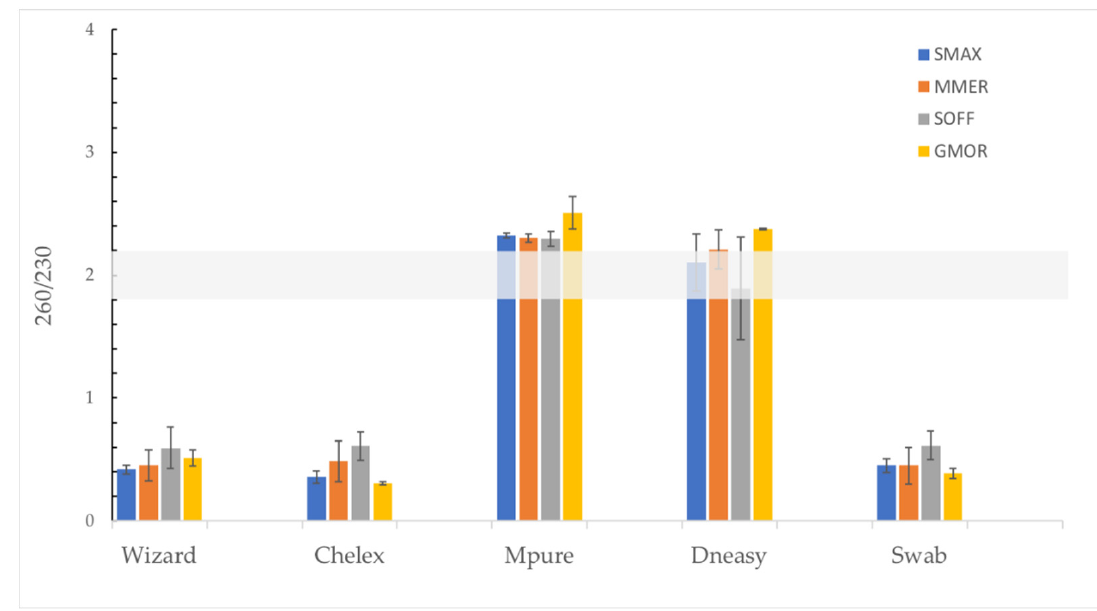
Figure 6. Ratio 260/230 of the tested DNA extraction methods per species. Data are presented as mean ± SD of individuals per species. Scophthalmus maximus (SMAX), Merluccius merluccius (MMER), Sepia officinalis (SOFF) and Gadus morhua (GMOR).